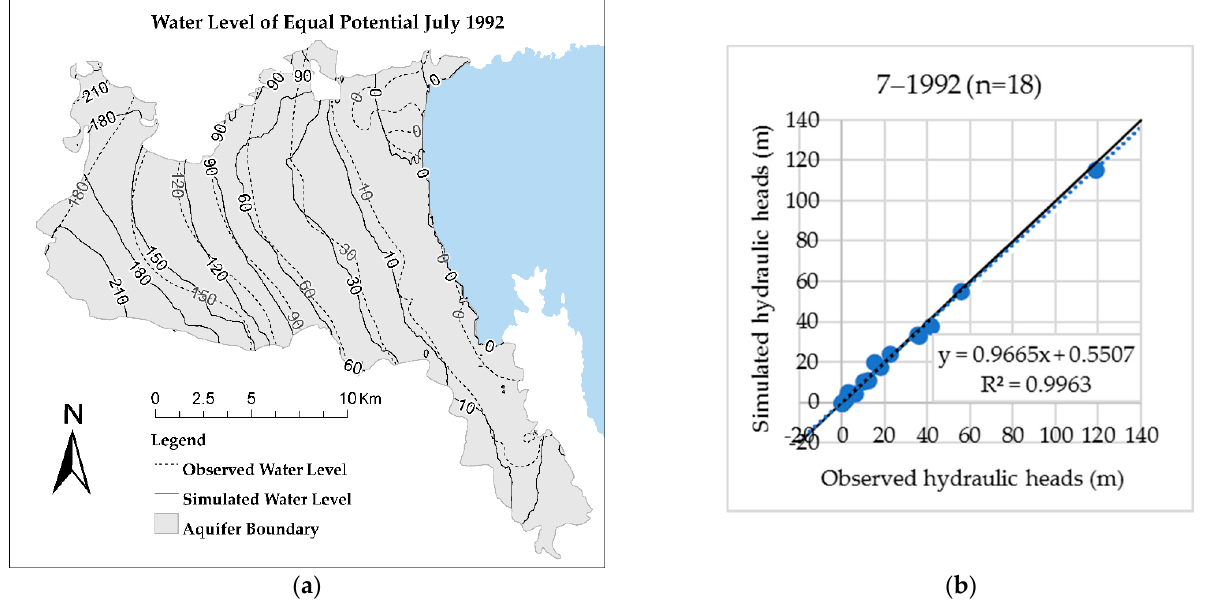
Figure 9. ( a ) The water level of equal potential for July 1992 and ( b ) scatterplot of simulated against observed water table values.